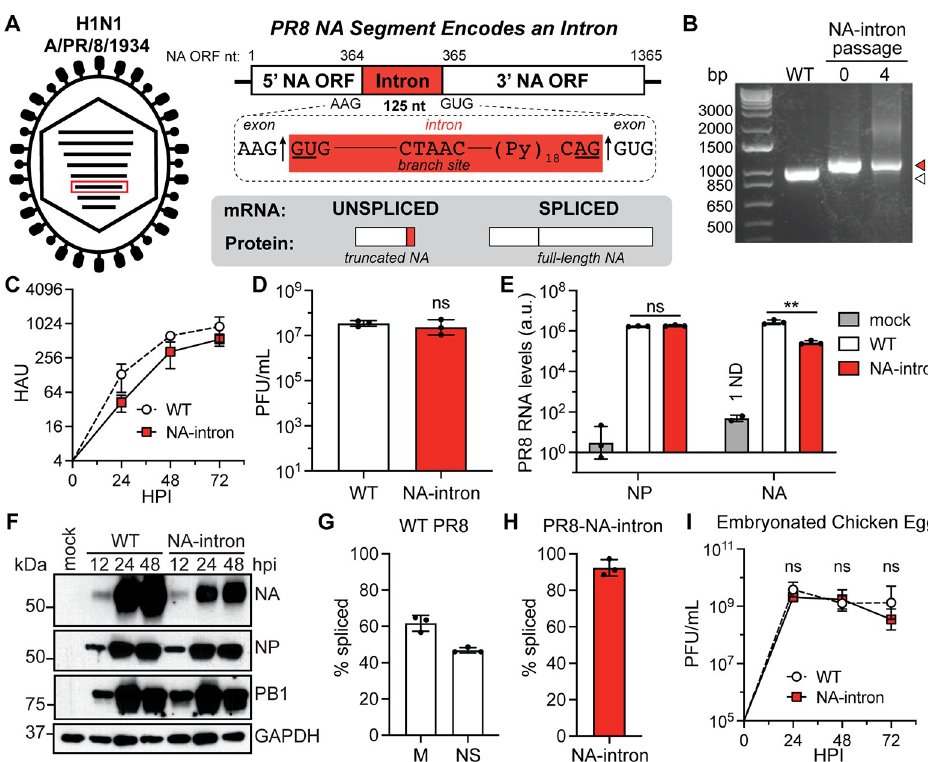
Fig 1. An artificial intron can be inserted into the IAV segment 6. (A) Diagram of the A/Puerto Rico/8/1934 H1N1 influenza A virus (IAV) segment 6/NA containing an intron and its protein products. ORF, open reading frame. (B) RT-PCR of WT PR8 virus (white) and PR8-NA-intron virus (red) segment 6/NA at passages 0 and 4 from serial PR8-NA-intron virus infections (MOI = 0.01, multicycle, 72h passages) on MDCK cells (representative of three independent experiments). (C) Growth kinetics of WT PR8 and PR8-NA-intron virus infections (MOI = 0.001, multicycle) on MDCK cells, measured using HA assays (mean with SD, n = 3 independent experiments). HAU, hemagglutination units; HPI, hours post-infection. (D) End point titers of WT PR8 and PR8-NA-intron virus infections (MOI = 0.01, multicycle, 72h) on MDCK cells, measured using plaque assays (mean with SD, n = 3 independent experiments, unpaired Student’s t-test). PFU, plaque forming units. (E) PR8 NA and NP RNA levels from mock, WT PR8, PR8-NA-intron virus infections (MOI = 2, single cycle, 8h) on MDCK cells, measured using one-step RT-qPCR (mean with SD, n = 3 independent experiments, unpaired Student’s t-test). Arbitrary units (a.u.) determined relative to 18S; ND, not determined. (F) Western blots for PR8 NA, NP and PB1 proteins from mock, PR8 WT, and PR8-NA-intron virus infections (MOI = 0.01, multicycle) on MDCK cells (representative of three independent experiments). GAPDH was used as a loading control. (G) PR8 segment 7/M and segment 8/NS mRNA splicing rates from WT PR8 virus infections (MOI = 2, single cycle, 8h) on MDCK cells, measured using two-step RT-qPCR (mean with SD, n = 3 independent experiments). (H) PR8 segment 6/NA-intron mRNA splicing rates from PR8-NA-intron virus infections (MOI = 2, single cycle, 8h) on MDCK cells, measured using two-step RT-qPCR (mean with SD, n = 3 independent experiments). (I) Growth kinetics of WT PR8 and PR8-NA-intron virus infections (100PFU) in embryonated chicken eggs, measured using plaque assays (mean with SD, n = 3 eggs per group, unpaired Student’s t- test). For all panels: � P < 0.05, �� P < 0.001, and ns = not significant. conditions on MDCK cells ( Fig 1C and 1D ). Together, these findings demonstrate that IAV PR8 tolerates the introduction of a highly spliced intron in segment 6. The presence or absence of introns in influenza virus mRNAs is recognized to impact their transport and translation [4]. To determine if the addition of an intron impacted the transcrip- tion, replication, or translation of NA, we measured the RNA (using an assay that would not discriminate between mRNA, vRNA, and cRNA) and protein levels from WT PR8 or PR8-NA-intron virus-infected MDCK cells. We found there was a modest reduction in NA RNA expression levels and a corresponding decrease in NA protein levels between our PR8-NA-intron virus and the WT PR8 virus ( Fig 1E and 1F ).